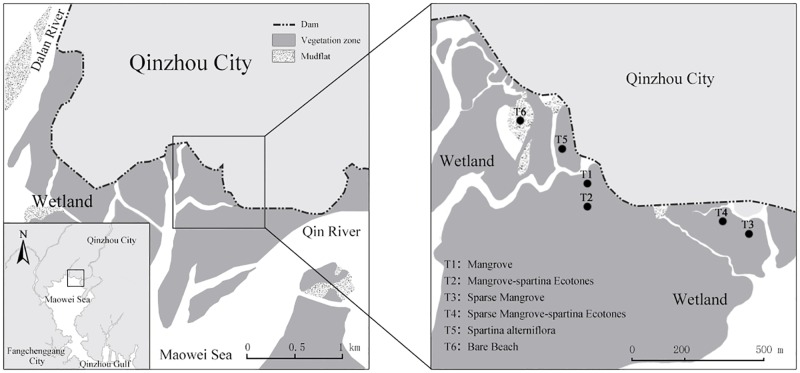
Location of sampling sites in the Maowei Sea National Ocean Park.The study area was drawn using Photoshop software, with remote sensing data downloaded from web (http://map.51240.com/) without copyright restrictions.